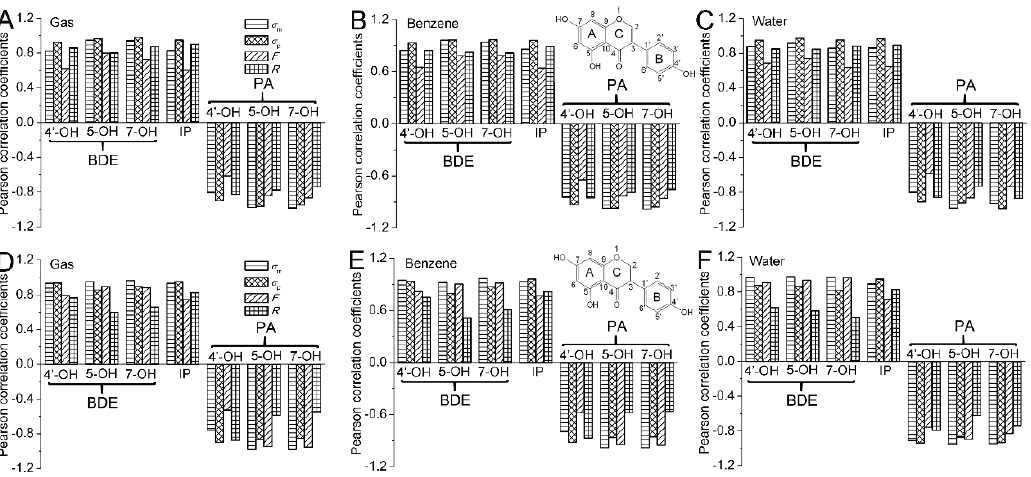
a The data in bold and underline represents the lowest BDEs.